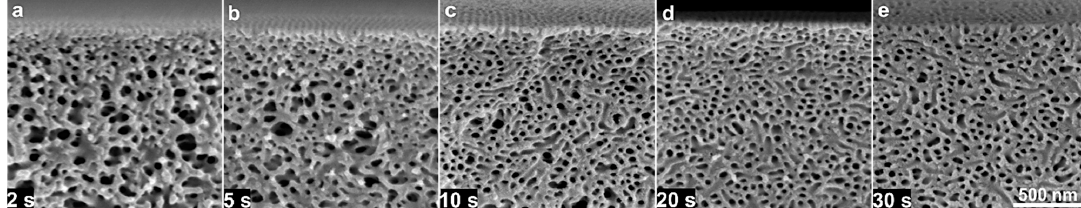
Figure 10. ( a – e ) SEM micrographs of the surfaces of cross-sections of the flat sheets cast using block copolymer solution of 22 wt% PS- b -P4VP 19170 in DMF/THF 1/1 (wt/wt). The casting parameters were Q g = 2.0 L/min for t g of 2–30 s.